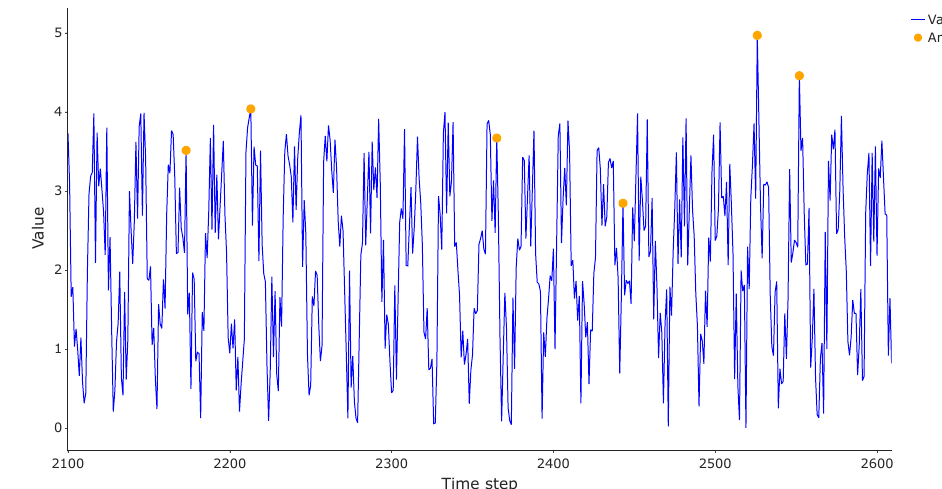
Figure 14. Example of a noisy time series from synthetic data set